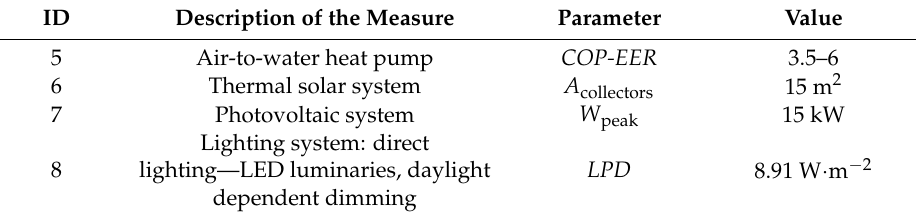
Table 4. Properties of the energy efficiency measures for the technical building